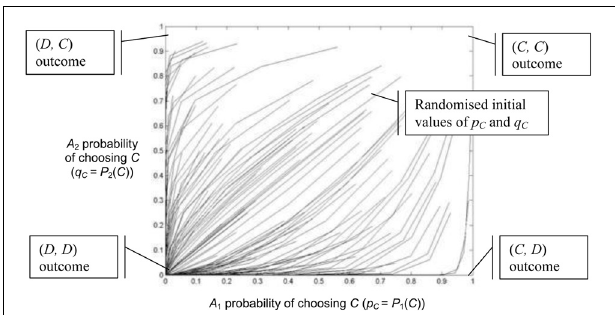
FIGURE 5 | Simulation of one hundred pairs of agents playing thirty iterations of the Prisoner’s Dilemma game. All agents have I ∗ j = 4 . 0, but initial values of p C and q C are